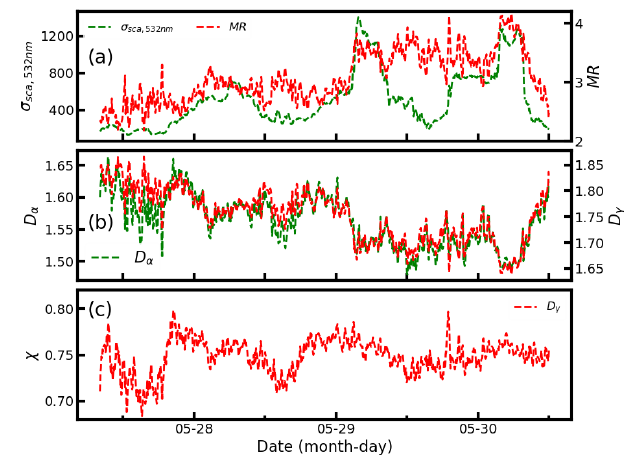
Figure 3. Measured time series of (a) σ sca and MR, (b) D α and D γ , and (c) χ .